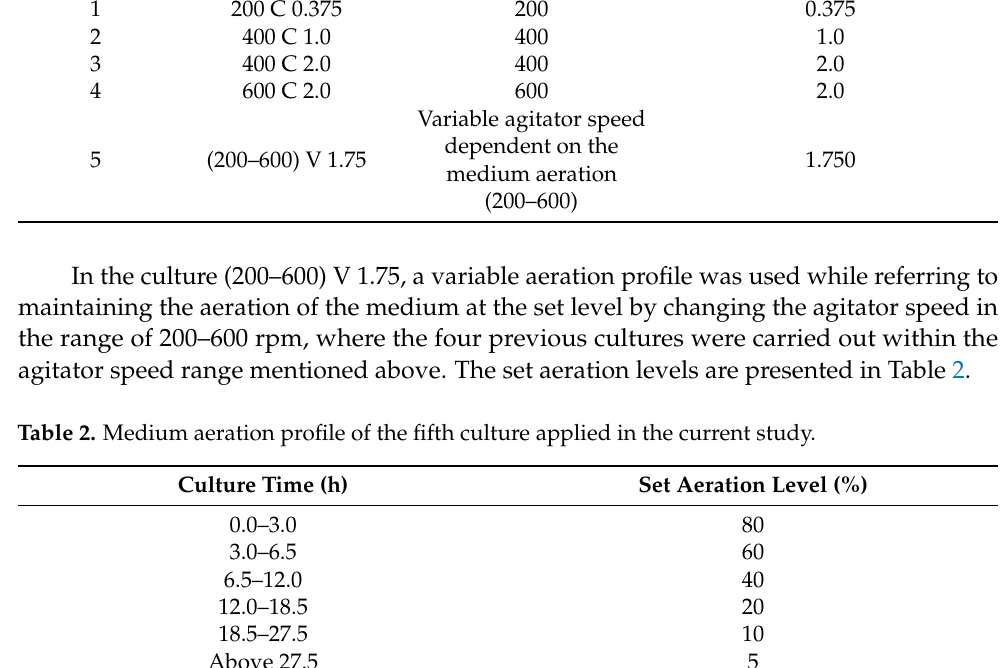
Table 1. Cultures conditions regarding medium aeration applied in the current study. Culture No.